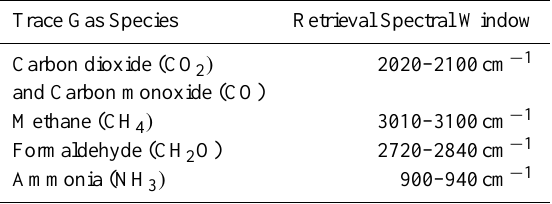
Table 2. Spectral windows used for the forward model-based re- trieval of biomass burning plume trace gas column amounts from the measured single beam FTIR spectra, selected from those used in previous closed-path biomass burning studies (e.g. Yokelson et al., 1997; Goode et al., 2000). Potentially interfering species (most importantly water vapour) were also included in the forward model